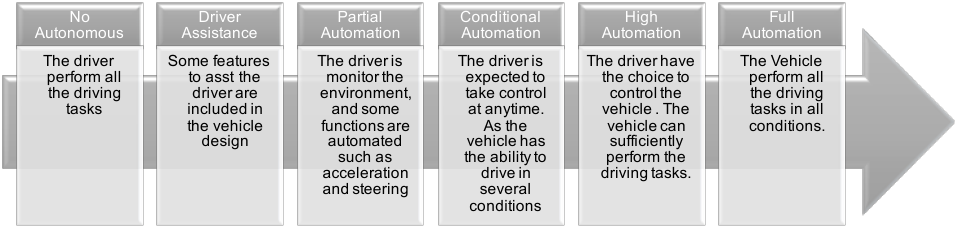
Figure 14. The classification of autonomous vehicles starting from the no automation to the highest automation category